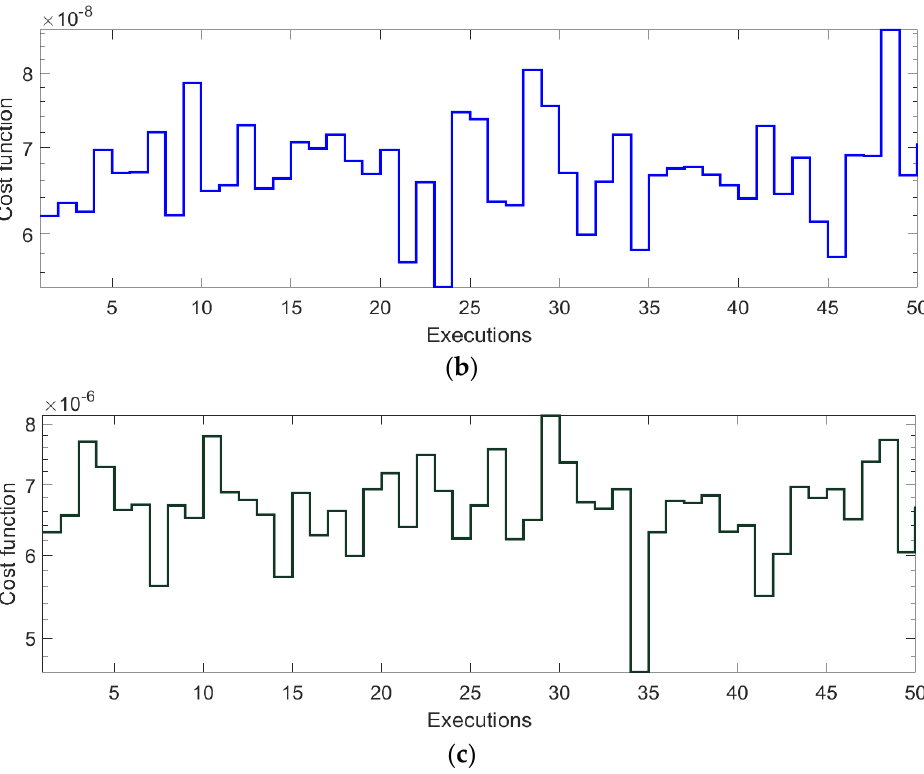
Figure 9. Monte Carlo simulation results for 0.1 λ ( a ) 200 dB ( b ) 70 dB ( c ) 50 dB.